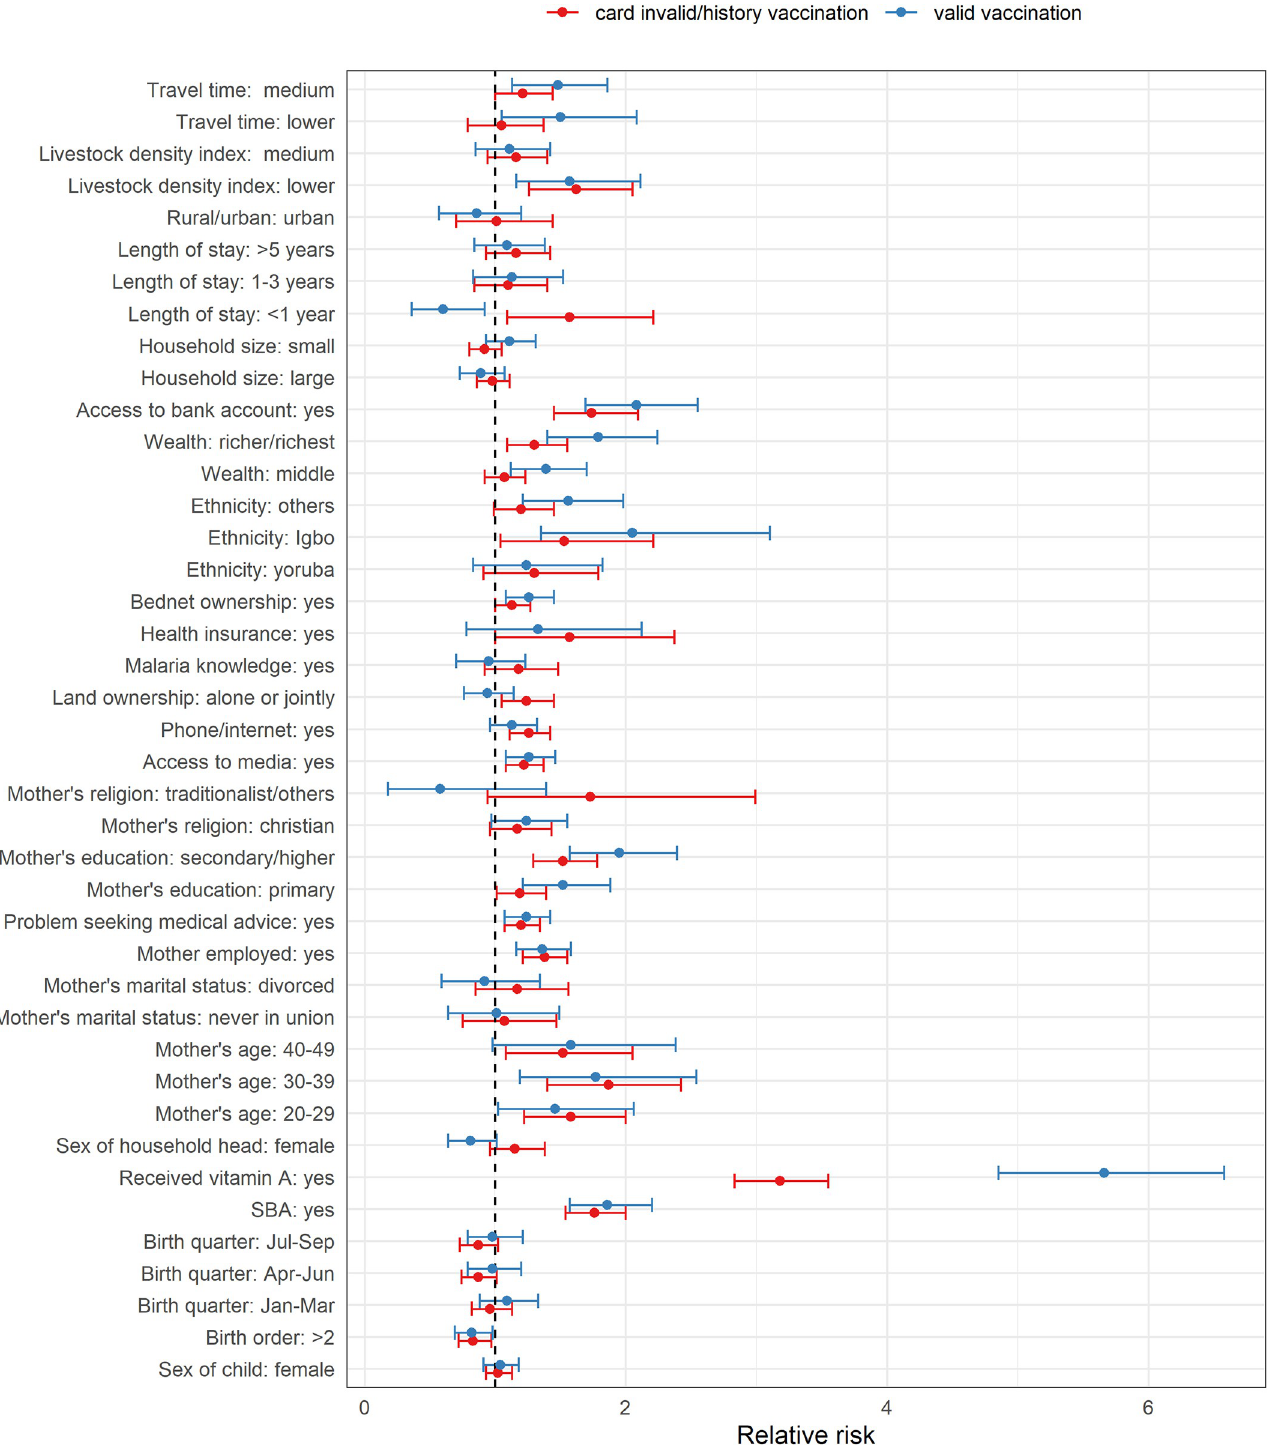
PLOS ONE | https://doi.org/10.1371/journal.pone.0269066 May 25, 2022 12 /